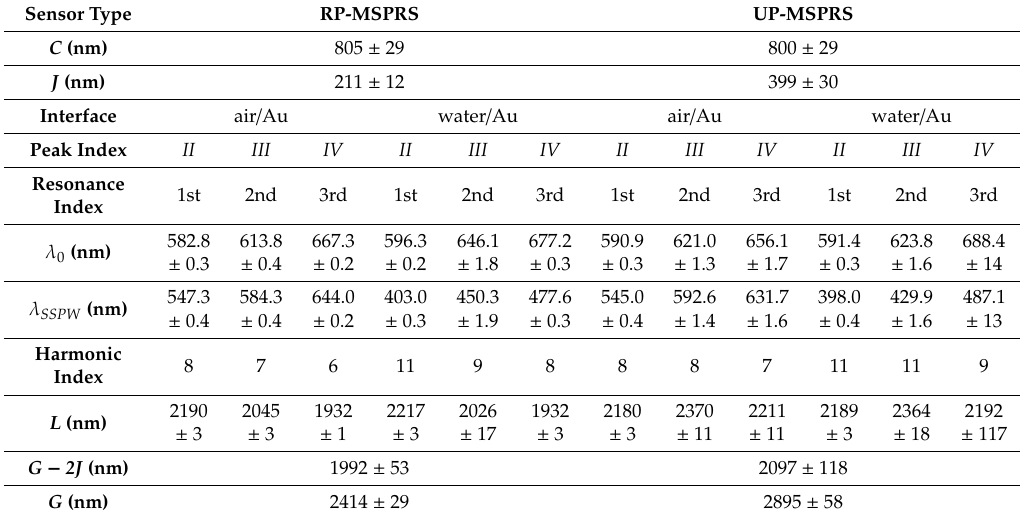
Table 5. Summary of concepts, calculations, and measurements for both sensors studied in Section